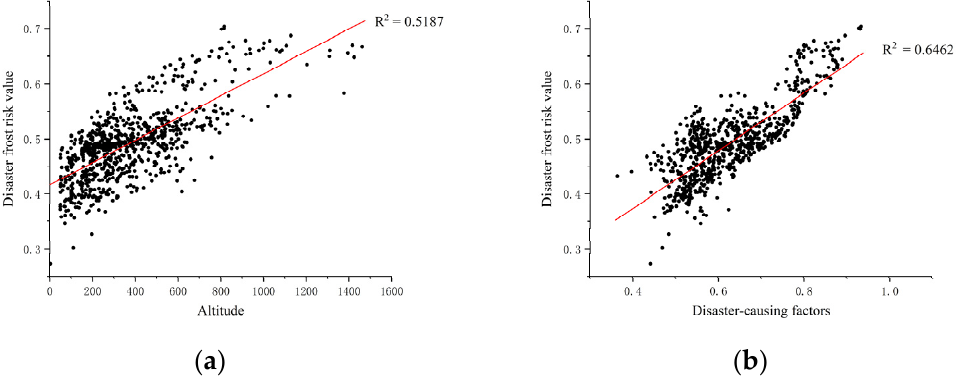
Figure 8. Correlation between frost disaster risk value and different factors: ( a ) Frost hazard risk value and altitude correlation; ( b ) The correlation between frost disaster risk value and disaster- causing factors.